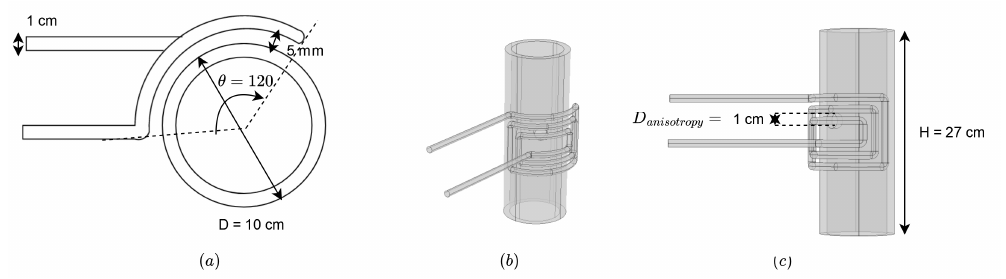
Figure 1. 3D geometry analyzed with FEM: XY-section as upper view ( a ), side view ( b , c ) and timelapse of an anisotropy